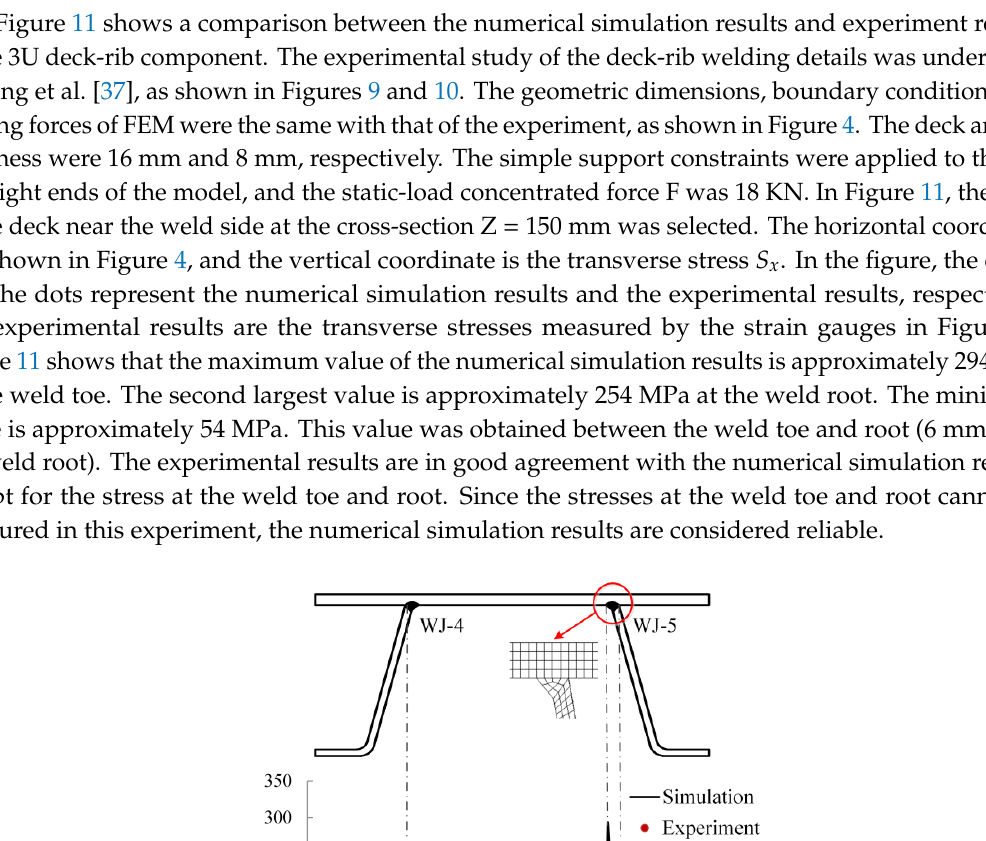
Figure 10. Strain gauges distribution (units: mm).